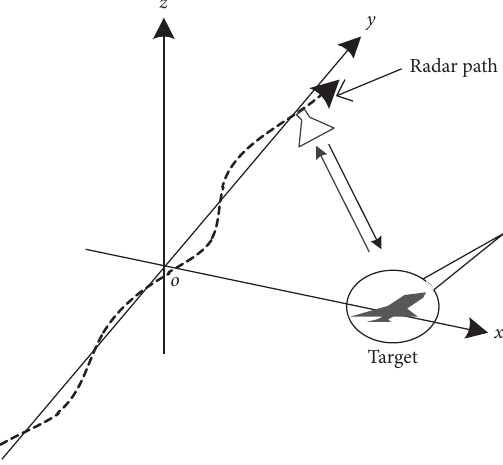
Figure 6: Twenty-eight-point target